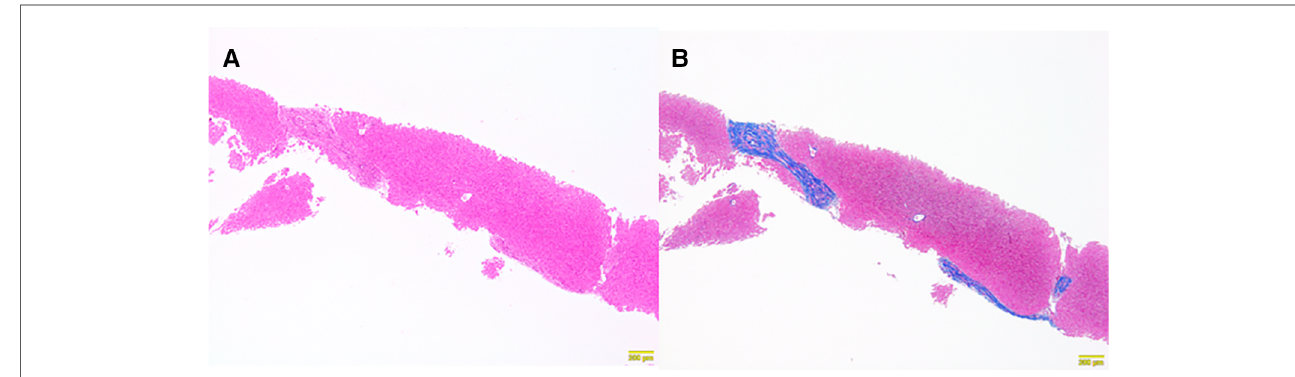
FIGURE 3 Histopathological fi ndings of a needle liver biopsy specimen obtained six months later. Chronic hepatitis and fi brosis, F2 – 3, A1. ( A ) Persistent portal area enlargement was observed. The in fl ammatory fi ndings had improved (Hematoxylin Eosin staining ×10). ( B ) Persistent bridging fi brosis was observed (AZAN staining